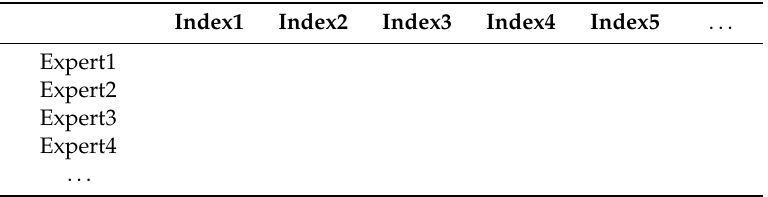
Table 1. Collection of experts’